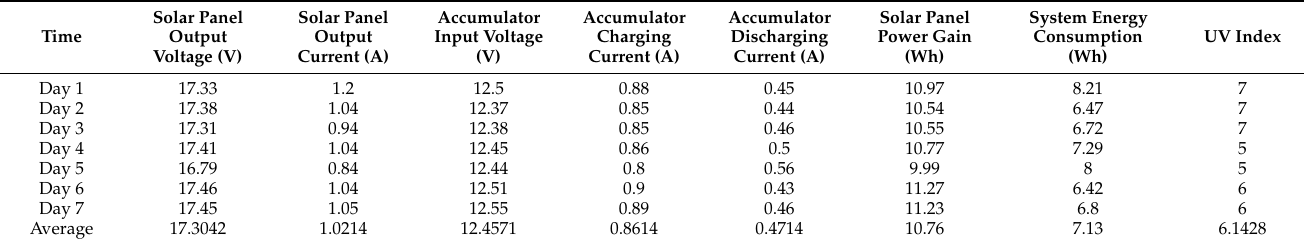
Table 2. Experimental results regarding Solar Panel Energy Generation and Storage, as well as System Energy Consumption during the Mostly Sunny Week [21]. Solar Panel Time